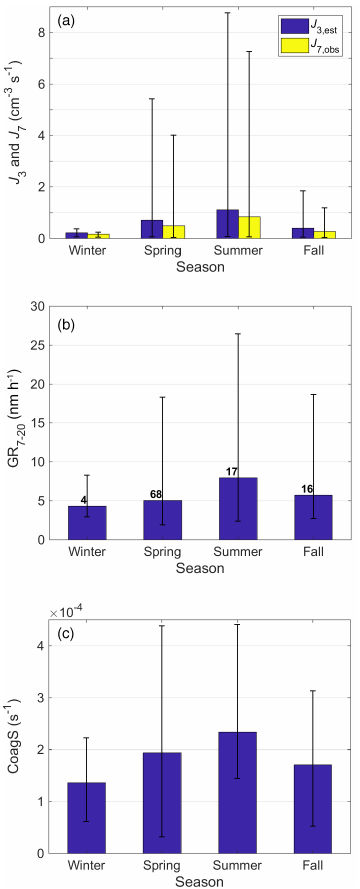
Figure 5. Seasonal mean values of different parameters for NPF days at Puijo: (a) estimated formation rates of 3nm particles ( J 3 , est ) and observed formation rates of 7nm particles ( J 7 , obs ) . (b) Growth rate of the particles within size range 7–20nm. (c) Coagulation sink (CoagS) of 7nm particles. The height of the bars shows the mean values of data points (i.e., mean values during 07:00 to 19:00 of the J and CoagS values for 105 NPF event days) within each season, and the error bars indicate the values between minimum and maxi- mum of the data points. The numbers on top of each bar in middle panel indicate the number of the NPF events in corresponding sea- son. The same applies to Fig. 5a and